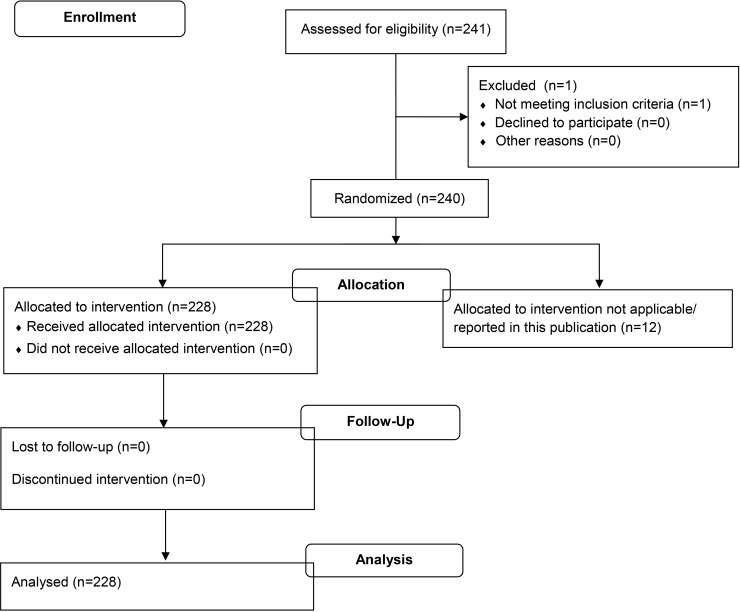
Ghent trial study flow chart.